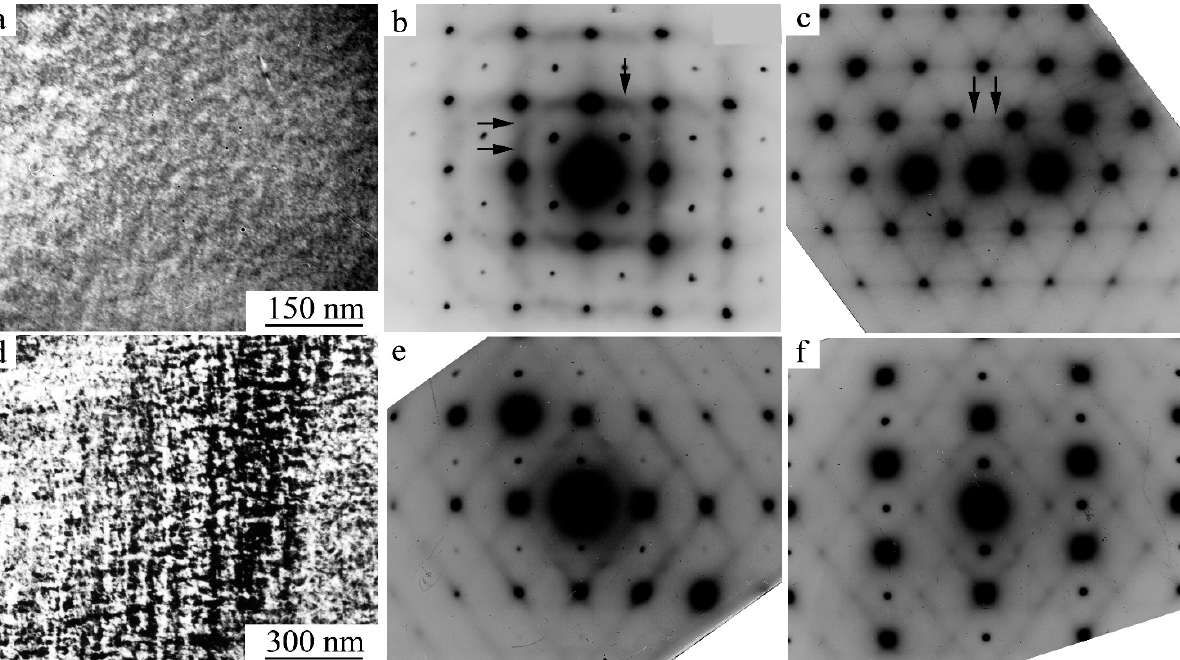
Ti 49 Ni 51 , and ( d ) Ti 49.4 Ni 50.6 quenched alloys, and also baro-induced B19’-martensite in ( e , f ) Ti 49.4 Ni 50.6 after treatment with a pressure of 6 GPa at RT [80].